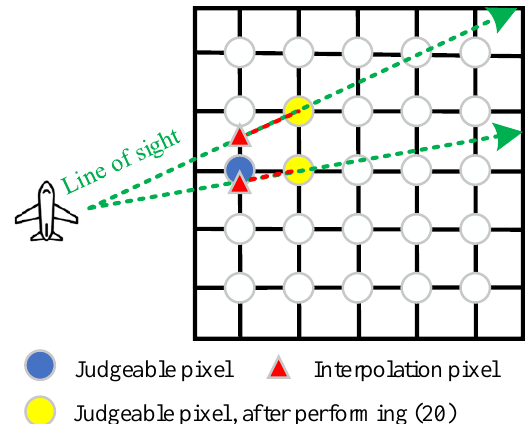
Figure 6. Schematic of the proposed interpolation algorithm. Step 2 : Depression angle interpolation (i.e., point target pixel interpolation) by (20): 1,